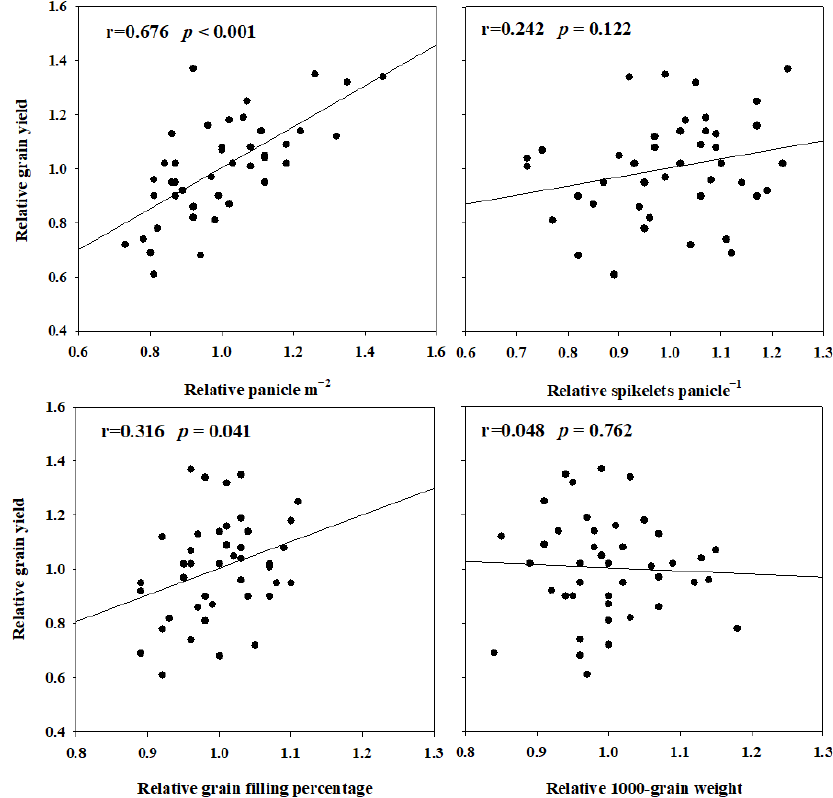
Figure 3. The relationship of the relative grain yield (RGY) with relative panicle m − 2 (RP), relative